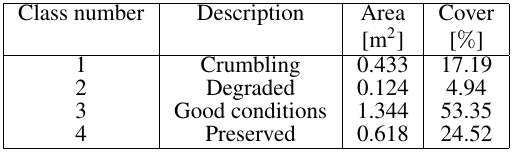
Table 2. Area and percentage cover pertaining to each class.